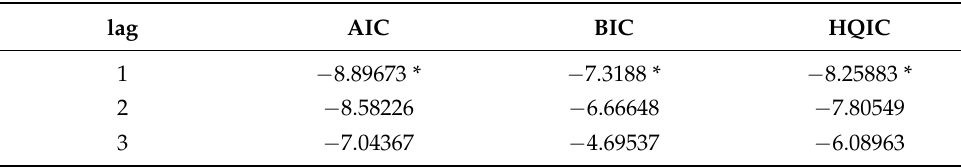
Table 5. Test results of optimal lag order selection.